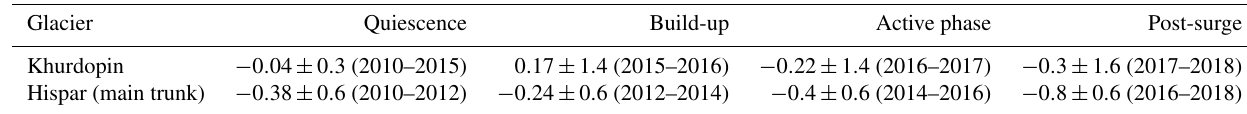
Glacier Quiescence Build-up Active